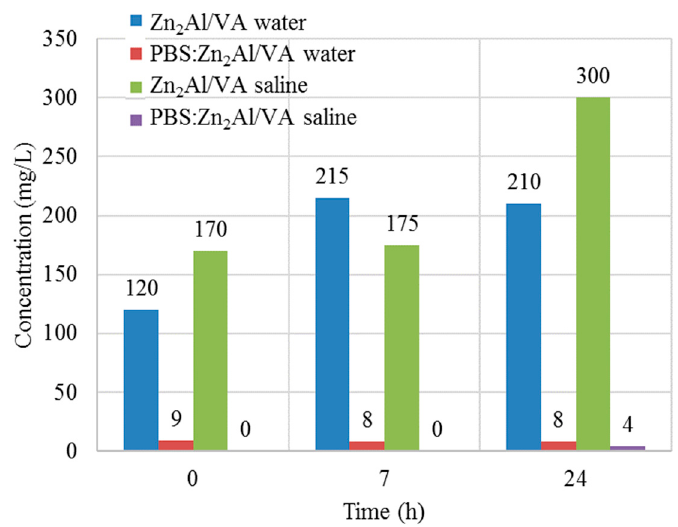
Figure 6. Concentration of vanillic acid evaluated by HPLC analyses in water or saline in which samples have been immersed. Table 3. Minimal inhibitory concentration (MIC) of vanillic acid (taken as a target bioactive molecule) vs E. coli and S. aureus . Strain growth is reported as turbidity in the McFarland scale. Values represent the difference between the turbidity measured after 24 h of incubation at 37 °C and that detected at the beginning of the incubation.